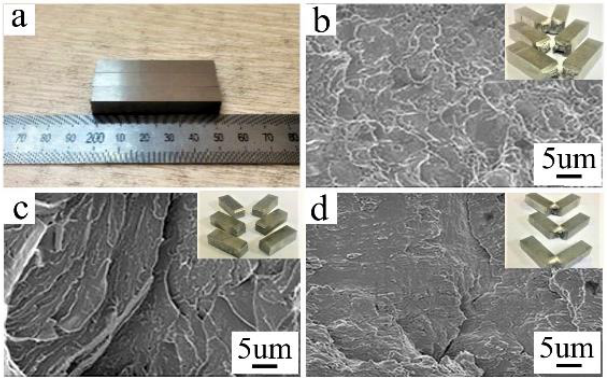
Figure 7. Impact test samples; ( a ) samples before testing, ( b ) fracture morphology of CLAM steels, ( c ) fracture morphology of EBW joints in welding state, ( d ) fracture morphology of EBW joints in quenching and tempering state.